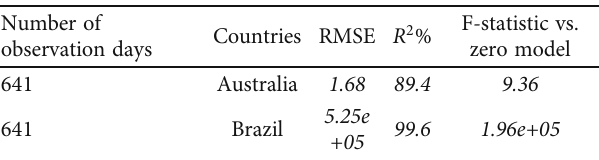
Table 5: Estimated results of the logistic model to predict COVID- 19.